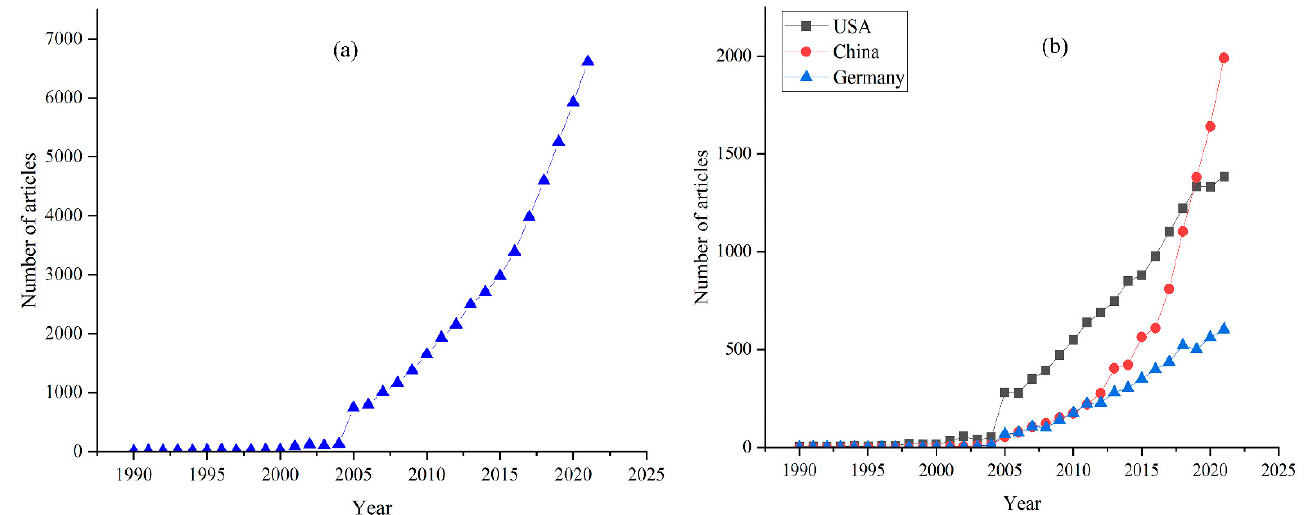
Figure 3. Statistics of selected articles. ( a ) Number of land use change articles published by year from 1990 to 2021, ( b ) Number of articles published by the three countries with the highest number of academic articles published on land use change, 1990–2021.